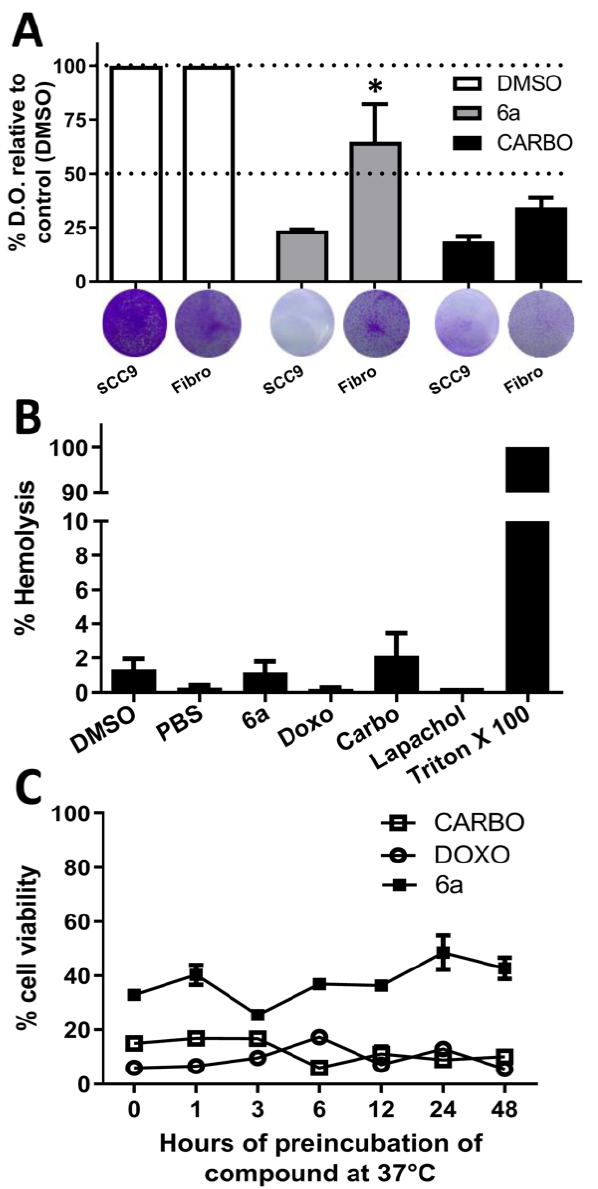
Figure 1. Clonogenic, hemolytic and stability assays. ( A ) Clonogenic assay: each column indicates the cell type (SCC-9 or normal fibroblast) treated with the indicated compound. Cells were treated with twice the calculated IC 50 (2 × IC 50 ) in SCC-9 cells ( 6a : 112.48 µ M). Top: graphical analyses of colony formation by absorbance reading as indicated in material and methods. Bottom: representative wells of colony formation assay stained with crystal violet. One-way ANOVA with Boferroni’s multiple comparison test was performed where all columns were significantly different from the control (DMSO) and * represents p < 0.0001. ( B ) Hemolytic activity of compounds at 400 µ M (approximately 10 × IC 50 ). One-way ANOVA with Dunnett’s Posttest was performed where all columns were significantly different from the control (Triton X) with p < 0.0001. ( C ) The stability of compound 6a was evaluated. The compound and the controls were diluted to 2 × IC 50 and incubated in the incubator at 37 ◦ C for 1/3/6/12/24/48 h prior to SCC9 cells treatment for more 48 h. As controls, Carboplatin, Doxorubicin and DMSO were used.